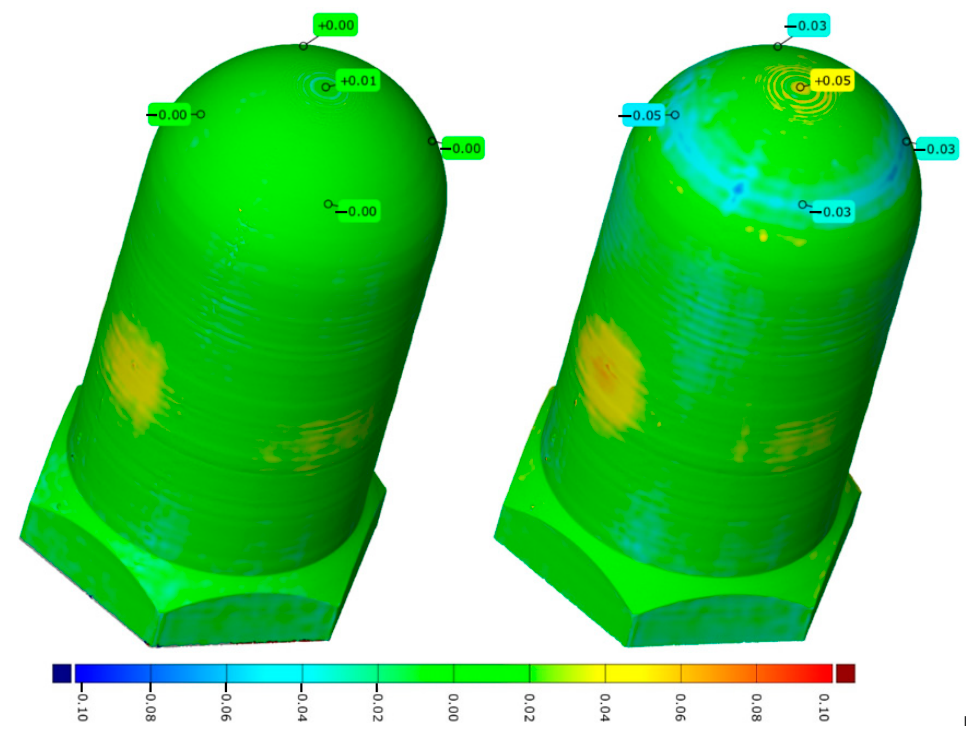
Figure 11. Wear of punch in Test 4_AP_1 between 5 ( left ) and 100 pieces ( right ). All values are in mm unit. Table 15. Wear of punch in Test 4_AP_1 between 5 and 100 pieces, measured values at given points. Test 4_AP_1 Wear Measurement